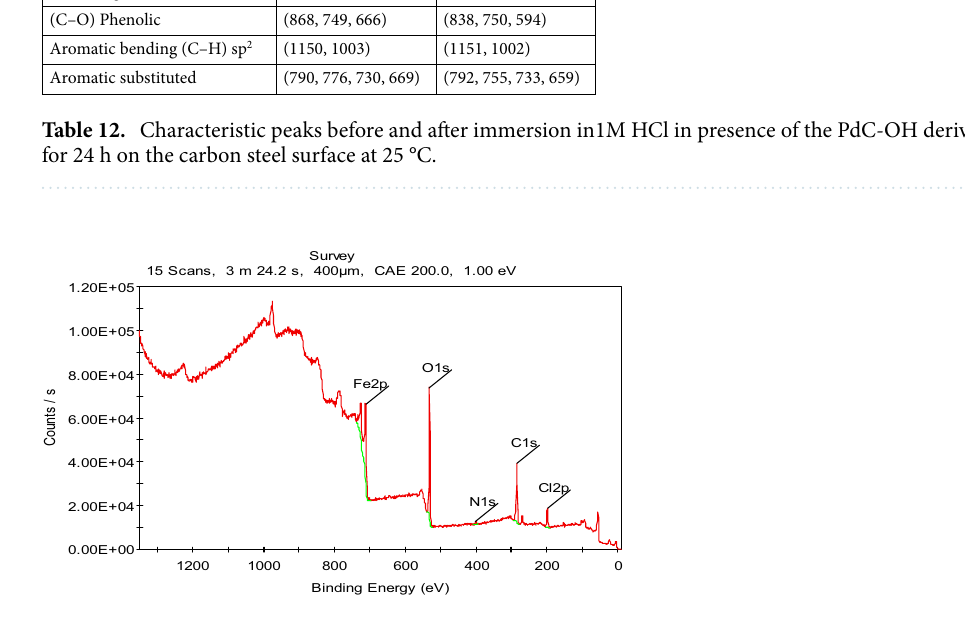
Figure 15. The XPS survey spectrum of PdC-OH compound adsorbed on the carbon steel in 1 M HCl at 25